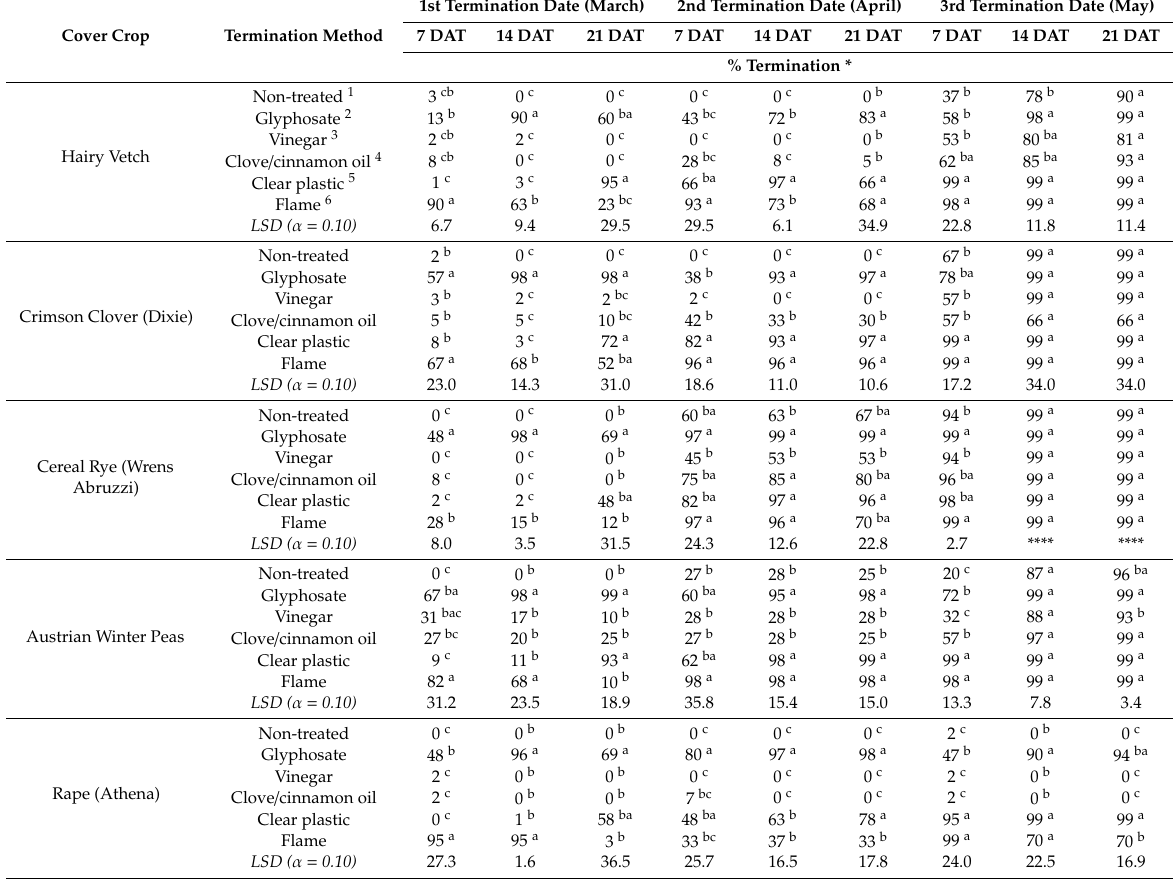
Table 3. Cover crop response to termination method by termination date in